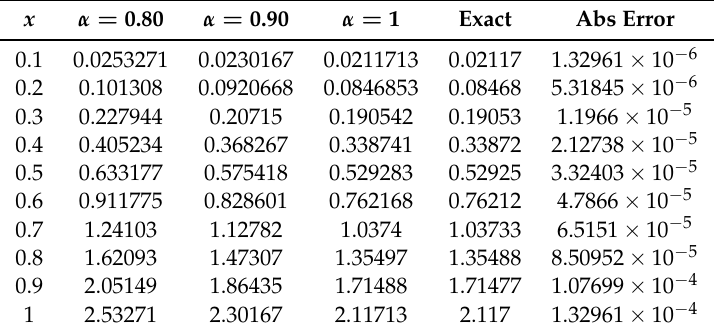
Table 9. Third order approximate results for different values of α at t = 0.75 of Example